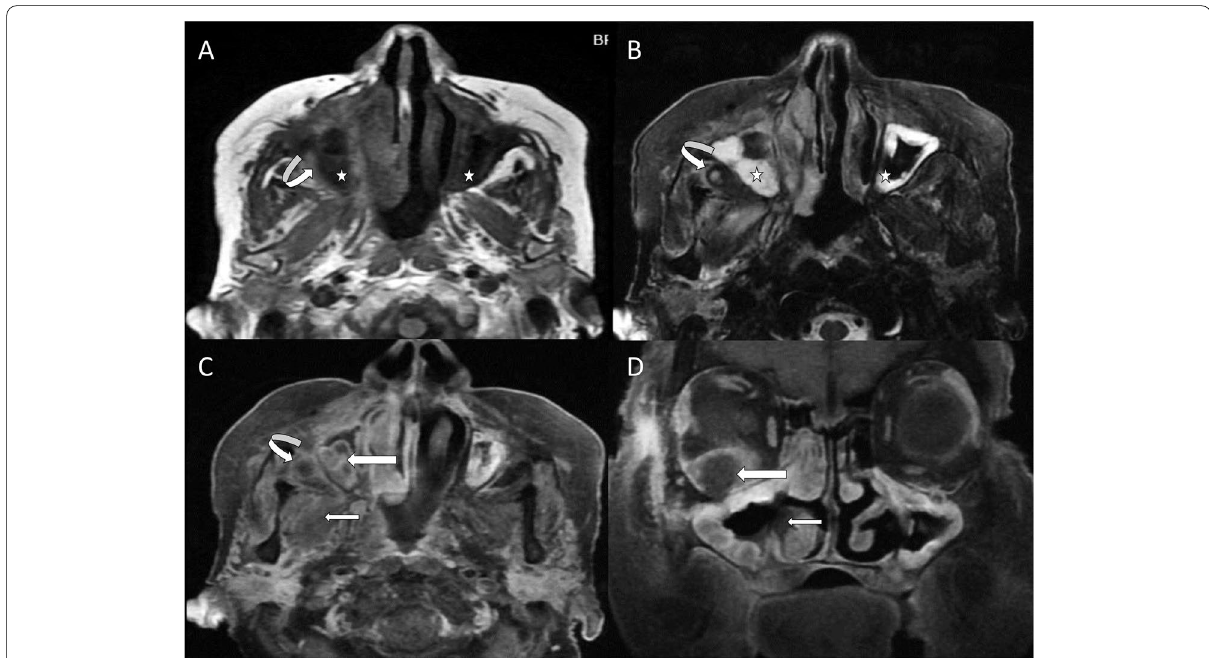
Fig. 1 Sinu-nasal mucormycosis with extension into retroantral fat, pterygoid muscle, and orbit. Axial T1-weighted image ( A ) shows hypointense mucosal thickening of the walls of bilateral maxillary sinuses (white stars) with the erosion of posterior wall of right maxillary sinus (curved arrow). Axial T2-weighted fat-saturated image ( B ) shows a well-defined hypointense lesion in right retroantral region (curved arrow) with central hyperintensity. Mucosal thickening appears hyperintense (white stars). Axial contrast-enhanced fat-saturated T1-weighted image ( C ) shows peripheral enhancement of the sinus mucosa (straight long arrow) and right retroantral lesion (curved arrow). Note the involvement of the right pterygoid muscle (straight short arrow) which appears bulky and shows heterogeneous enhancement. Coronal contrast-enhanced fat-saturated T1-weighted image ( D ) shows a peripheral enhancing lesion in the right orbit with central non-enhancing area (straight long arrow) suggesting intraorbital abscess formation. Part of the right inferior turbinate (straight short arrow) shows no enhancement (the “Black turbinate